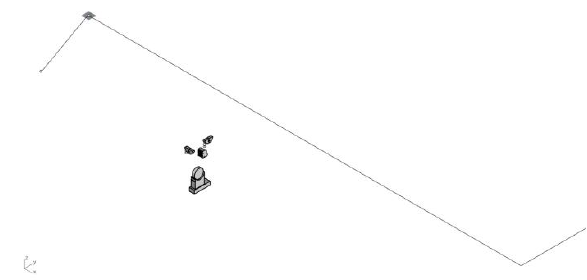
Figure 9. Balustrade path and irregular